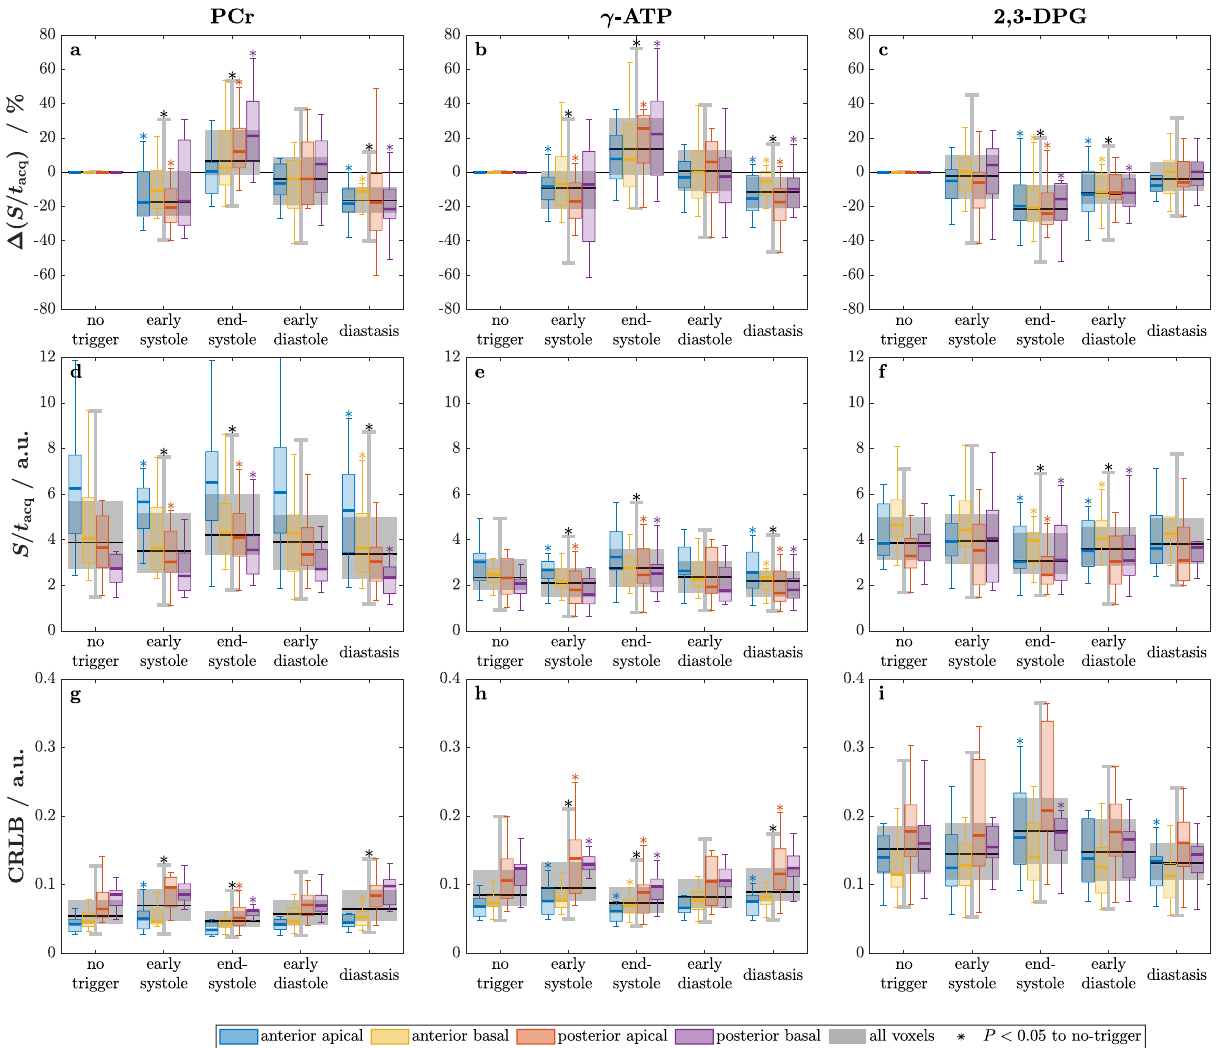
Figure 2. Metabolite signals S / t acq of PCr, γ -ATP and 2,3-DPG, and the respective CRLBs over the cardiac cycle for all subjects. ( a – c ) Signals as deviation in % from the respective untriggered signal. ( d – f ) Absolute signals to visualize the influence of voxel location. ( g – i ) CRLBs in units of the respective signals to indicate the fitting accuracy. Boxplots depict median (line), IQR (box) and 1.5 × IQR (whiskers) of the study cohort; outliers not